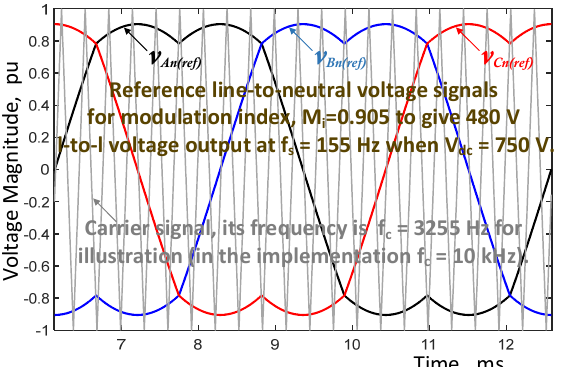
Figure 5. Application of SVPWM to the traction converter of LRTS described in this paper. Electronics 2022 , 11 , x FOR PEER REVIEW